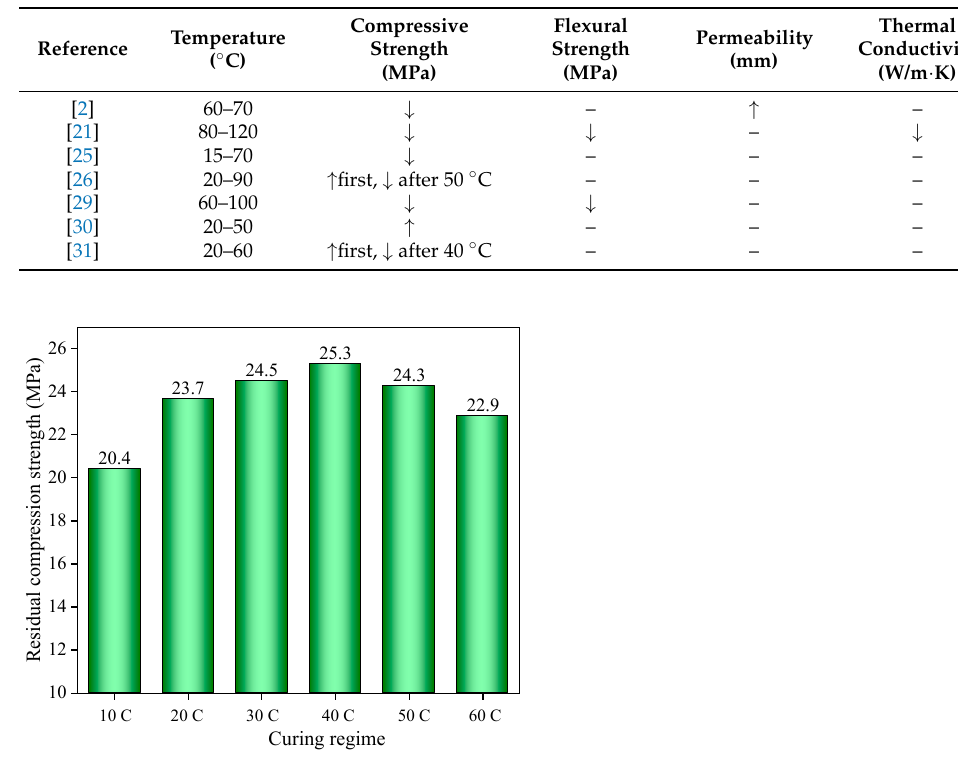
Figure 8. Residual compressive strength of SCC coated with ACP under different early curing regimes.